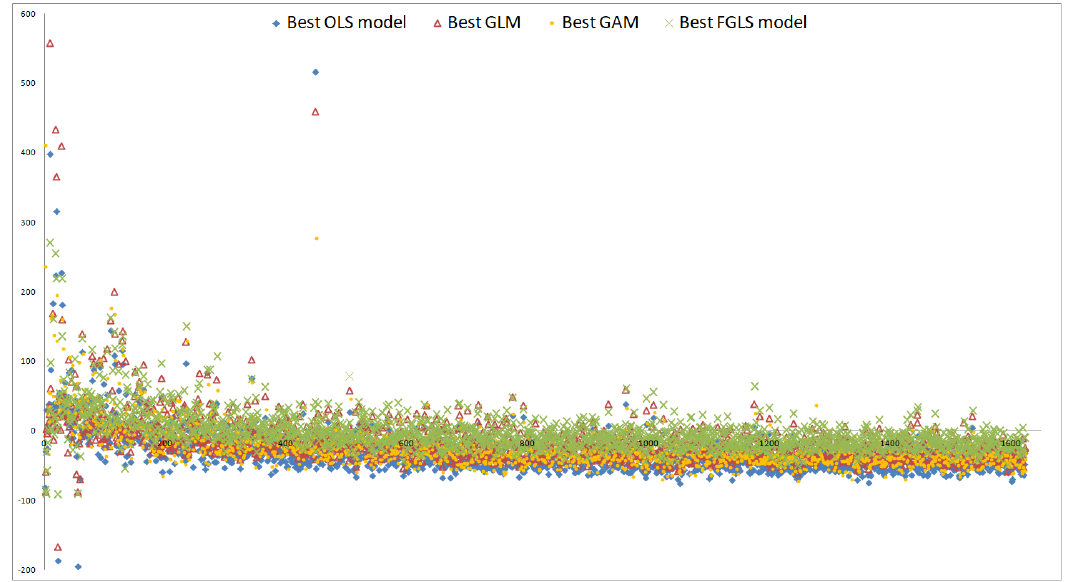
Figure 9. Residual plots on nested simulations set